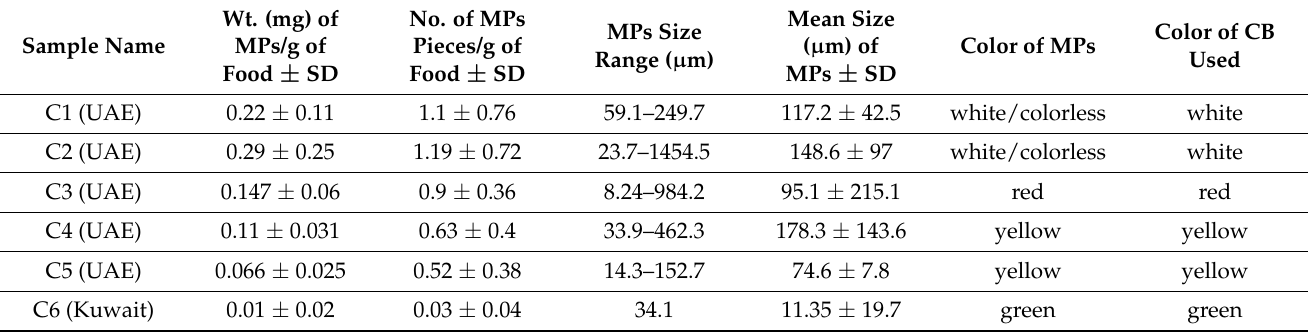
Table 1. Mass, number, size distribution and color of MPs in chicken meat samples.